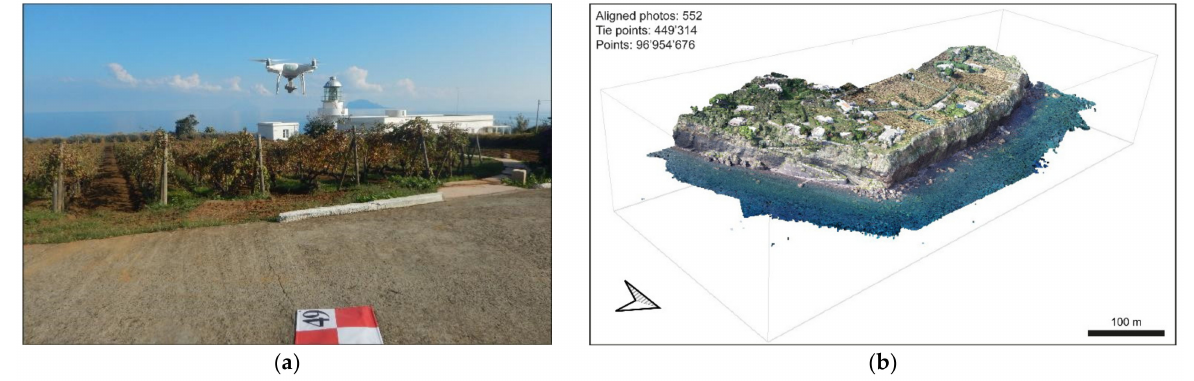
Figure 2. ( a ) The Phantom 4 Pro drone during its take–off in the flat courtyard of Capo Faro Estate; ( b ) Dense point cloud of the flight area in RGB colour, processed with the Agisoft Metashape